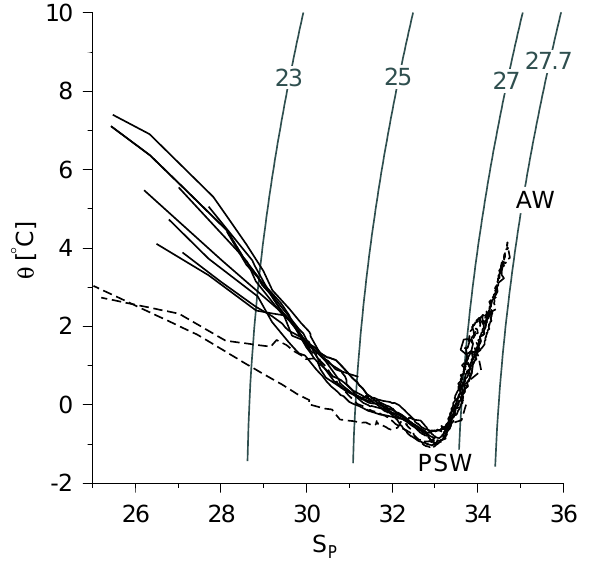
Figure 8. Potential temperature ( θ ) and salinity ( S P ) diagram of all profiles from the three fjords. The two stations in Timmiarmiut Fjord near the Heimdal tidewater outlet glacier (CTD14-01 and 14- 09) are shown with dashed lines. Temperature–salinity characteris- tics of two water masses, i.e., Atlantic water (AW) and polar sur- face water (PSW), are indicated and lines of constant density ( σ θ , kgm − 3 ) are